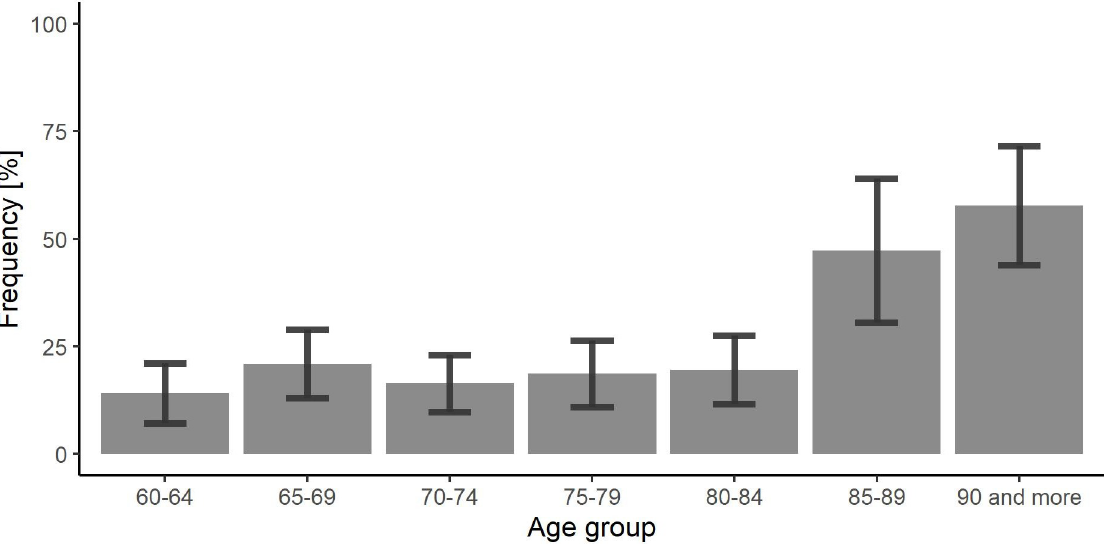
Fig 4. The frequency of untreated thyroid dysfunction in age